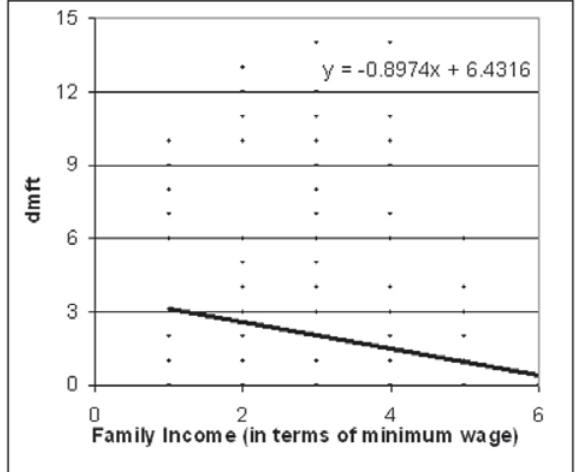
FIGURE 3- Family income and dmft index value.